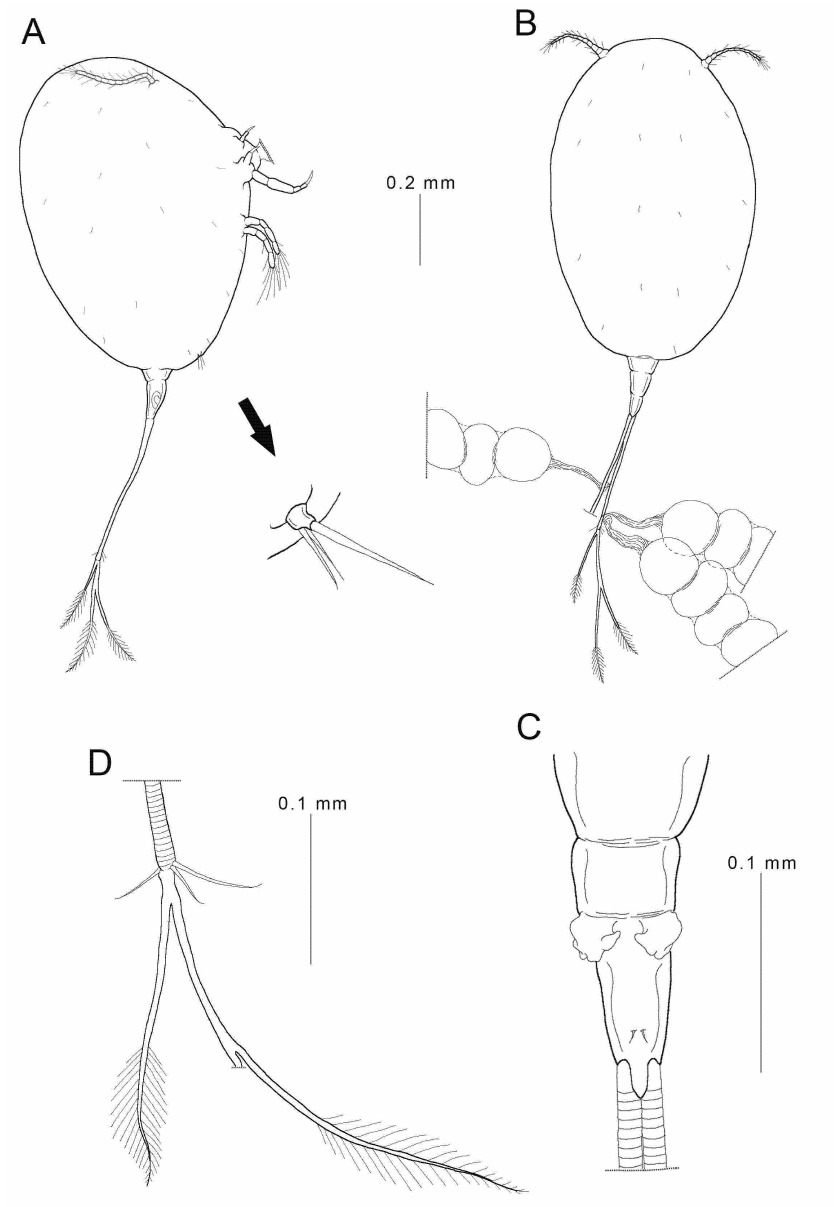
Figure 2. Female Choniomyzon taiwanensis n. sp. ( A ) Habitus, lateral (with enlarged leg 3); ( B ) female, habitus, dorsal (with three egg sacs); ( C ) urosome; ( D ) caudal ramus. Scale-bars: ( A , B ), 0.1 mm; ( C , D ), 0.02